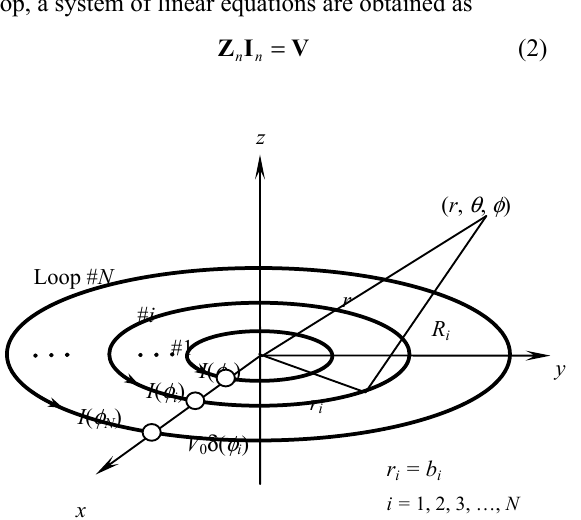
Figure 1: Geometry of the